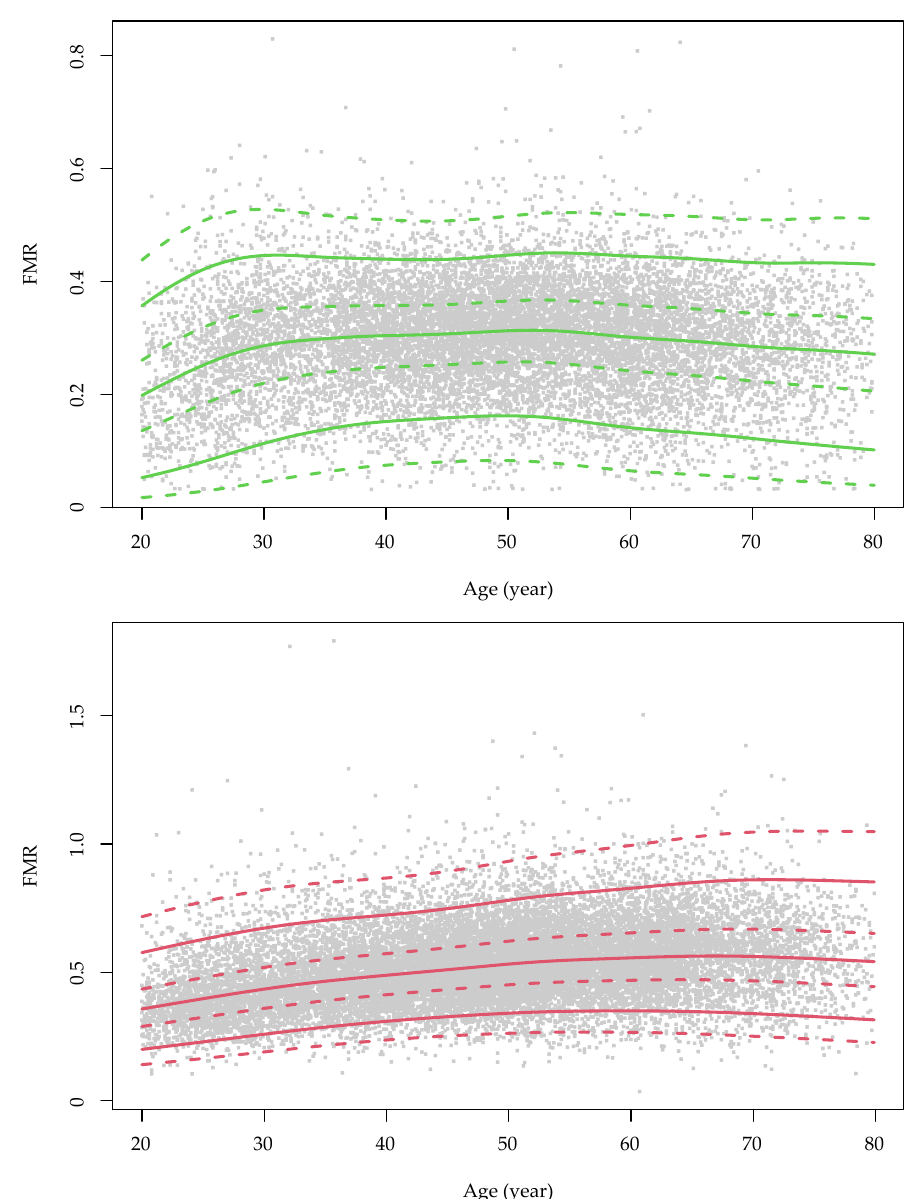
Figure 1. The sex-specific growth curve of the fat-to-muscle ratio over the course of ageing in the study population. FMR: fat-to-muscle ratio. The green color is for males and red is for females. The grey dots represent the distribution of the FMR values for each